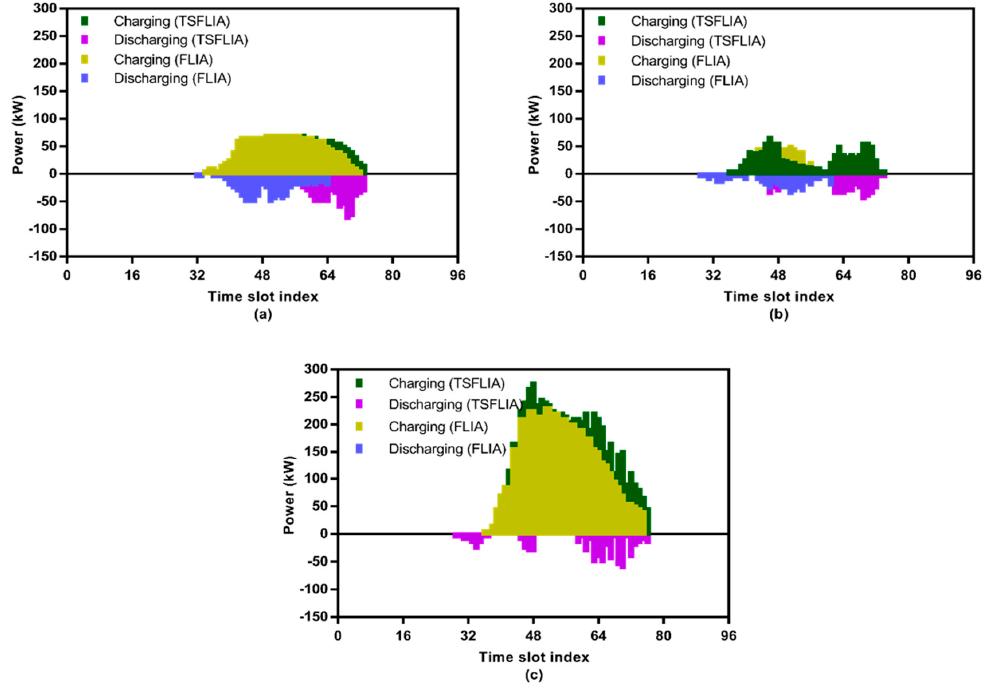
Figure 12. Charging and discharging operation of EVs in the PLs connected to the three buses: ( a ) Represents the PL connected to the bus #820; ( b ) Represents the PL connected to the bus #834; ( c ) Represents the PL connected to the bus #844.